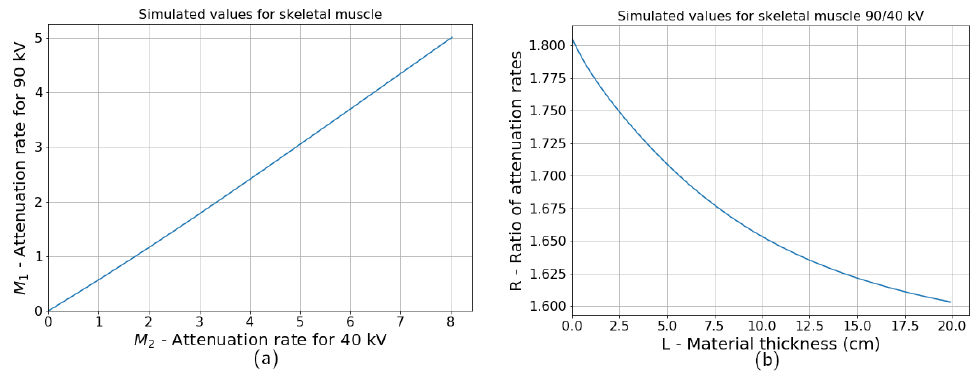
Figure 2. Correlation between the absorption of skeletal muscle for the X-ray tube voltages of 40 and 90 kV ( a ). The ratio between the attenuation rate is drawn as a function of thickness. The ratio is not constant due to a polychromatic spectrum ( b